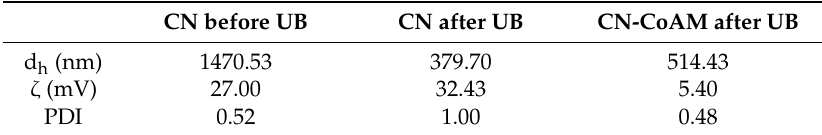
Table 2. d h , ZP and PDI of CN particles before ultrasonic bath along with CN and CN-CoAM particles after ultrasonic